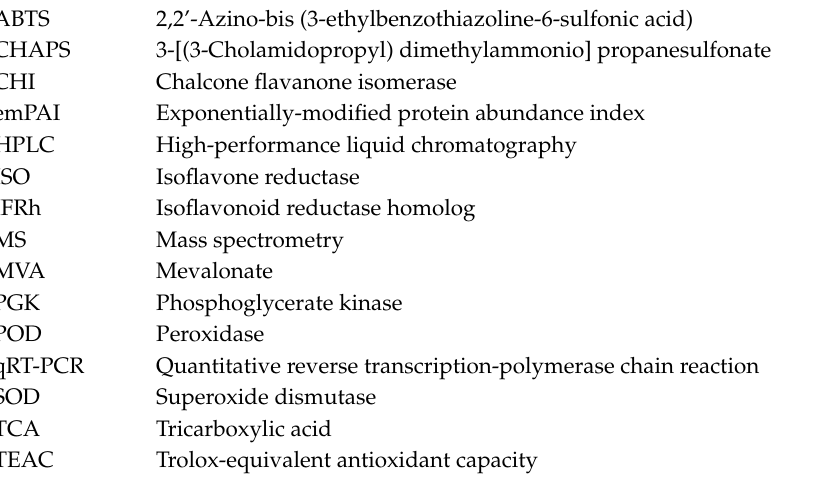
Supplemental Figure S2. Experimental design of the proteomic study. Supplemental Figure S3. Workflow of the gel-free/label-free proteomic methods in the present study. Supplemental Figure S4. Pie chart of functional categorization of leaf, branch, and root in Morus. Supplemental Table S1. Proteins Identified in the leaf of Morus by gel-free/label-free proteomic analysis. Supplemental Table S2. Proteins Identified in the branch of Morus by gel-free/label-free proteomic analysis. Supplemental Table S3. Proteins Identified in the root of Morus by gel-free/label-free proteomic analysis. Supplemental Table S4. Contents of total flavonoids in different organs of Morus . Supplemental Table S5. Primers of three genes used in this